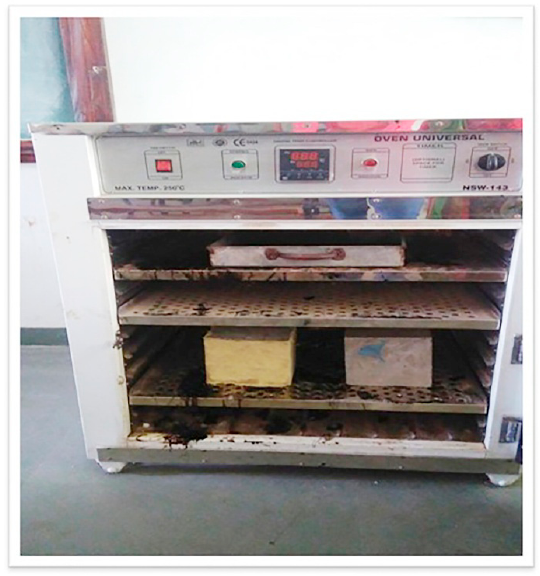
Table 8. Fire resistance test at 200 °C—1 h.